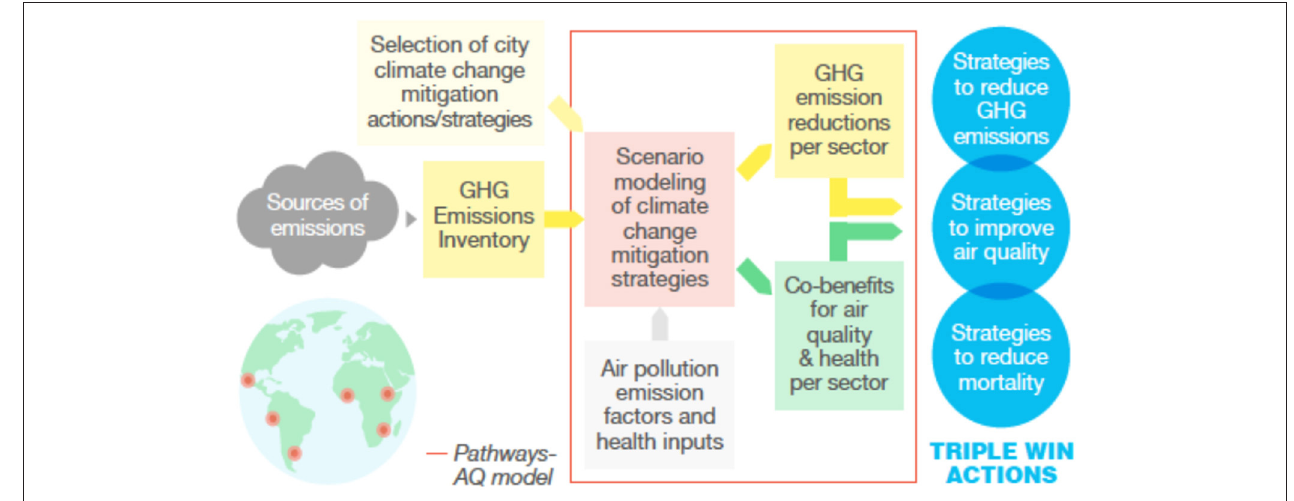
FIGURE 1 | Integrated framework for Climate Action Planning with Air Quality